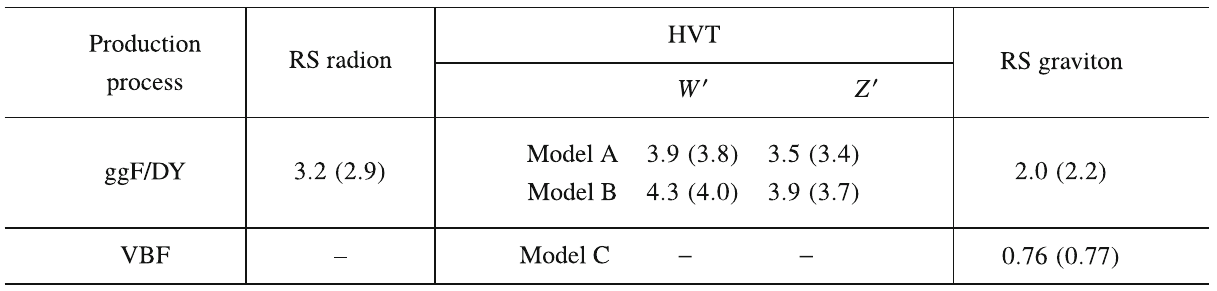
Table 5 Observed (expected) 95% CL lower limits on the mass, in TeV, of different resonances in the benchmark models studied. The symbol “ − ” means no limit is